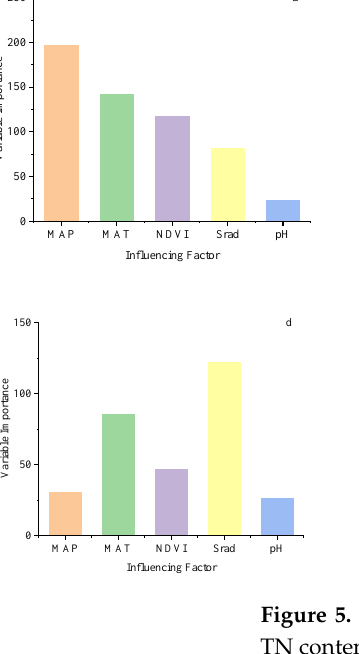
The SEM model study revealed that the model explained 27%, 36%, 15%, 31%, and 8% of the TN content in the five grasslands, respectively (Figure 6). The SEM model of TN in the Pontiac Savannah found that MAP had the highest effect on TN, with a load of 0.38, followed by Srad ( − 0.31), MAT ( − 0.17), and NDVI (0.13) in that order, with pH having the weakest effect on TN, with a load of only 0.01. With a load of 0.59, MAP had the largest effect on TN in the SEM model of TN in the Middle East Steppe. MAT ( − 0.23) was followed by Srad ( − 0.07) and NDVI (0.07), with pH having the weakest effect on TN, with a load